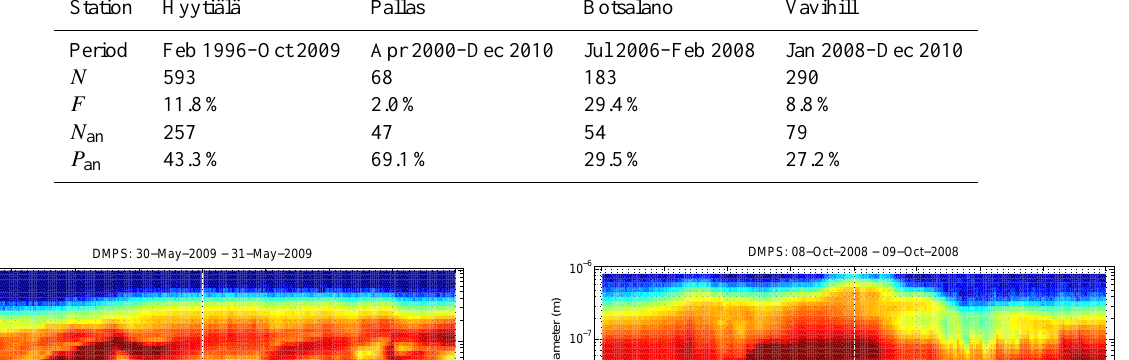
Table 1. Statistical details of the analyzed data. For each station, N denotes the total number of observed Type I nucleation event days during the period considered here, F gives the corresponding frequency of such days, N an denotes the total number of Type I nucleation event days selected for the analyses depicted in Figs. 5 and 6, and P an is the percentage of the Type I nucleation event days used in our analyses. Station Hyyti¨al¨a Pallas